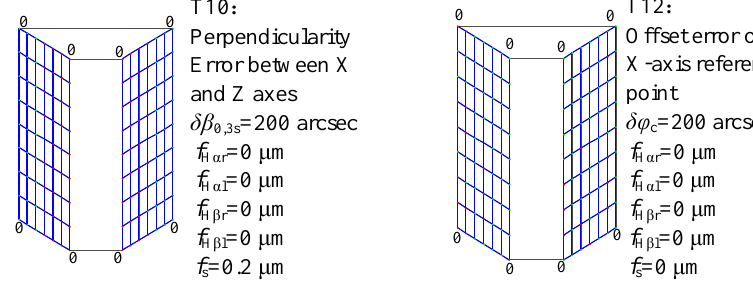
Figure 10. Deviations in tooth surface produced by assembly errors T4, T10, and T12. More characteristics were found by further analysis. (1) The deviation value of ground tooth surfaces produced by a single error term is the same on the left and right tooth surfaces. However, some deviation directions are the same, and others are opposite.